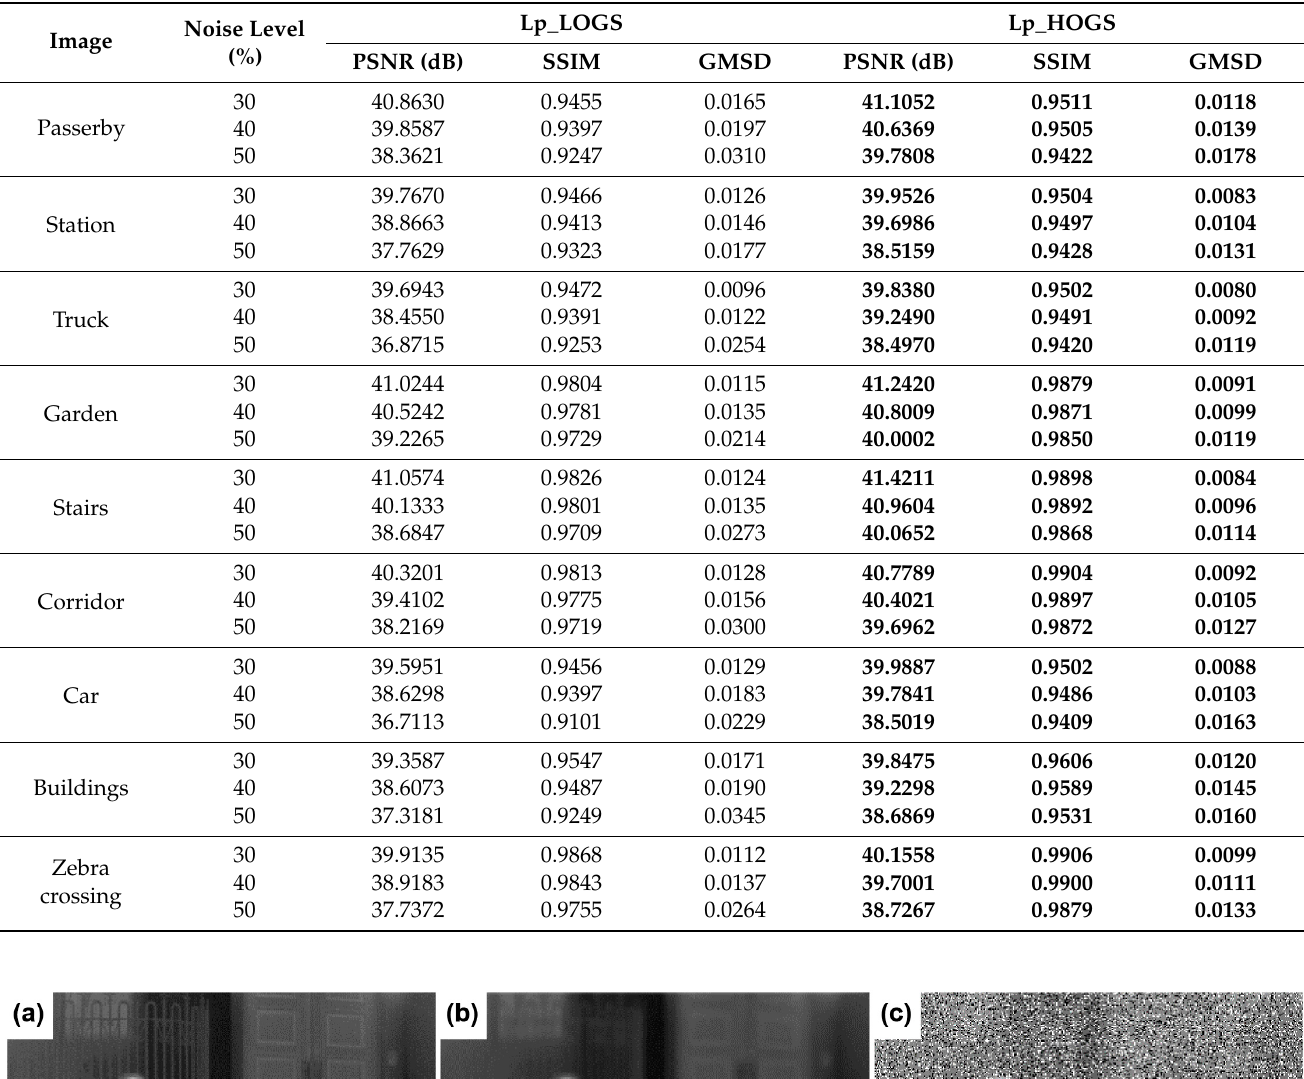
Table 1. The Lp_HOGS and Lp_LOGS deblurring effects on images with the 7 × 7 Gaussian blur. The optimal indicators for each condition are denoted in bold to facilitate data observation.